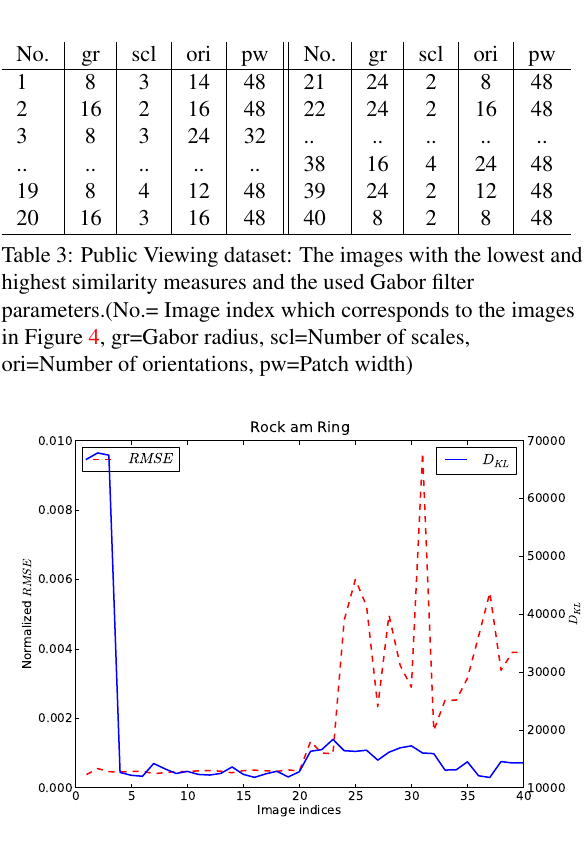
Figure 5: RMSE and D KL for the RockamRing dataset. Note the large D KL difference between images No. 3 and No. 4, but a near constant RMSE .